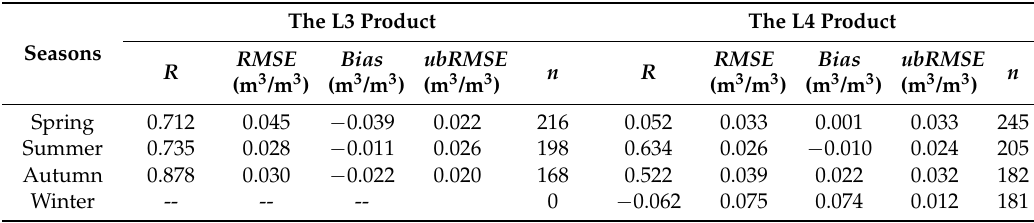
Table 4. Evaluation of daily average values from the SMAP L3 and L4 products at seasonal scale.